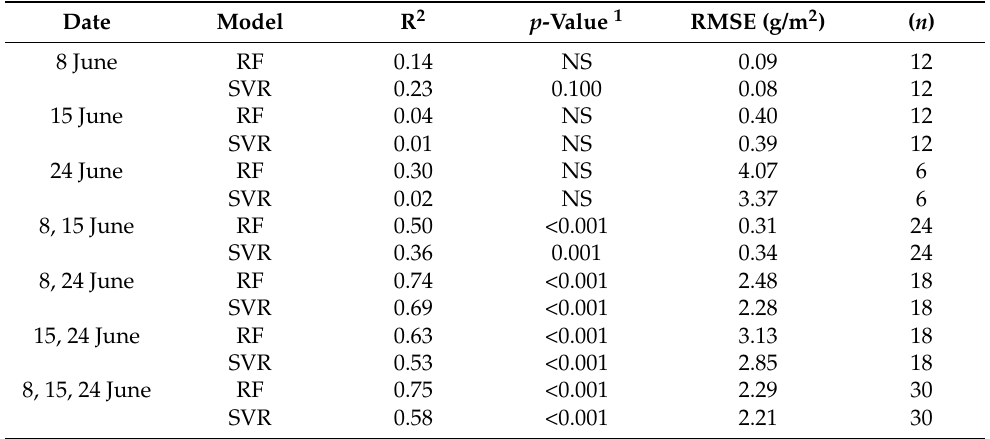
Table 5. Statistics for the validation of the canopy nitrogen model with all 29 variables including selected vegetation indices, the 5 Micasense bands, plant physiology variables, soil metrics, and topographic metrics as a function of the date and modelling approach (RF or